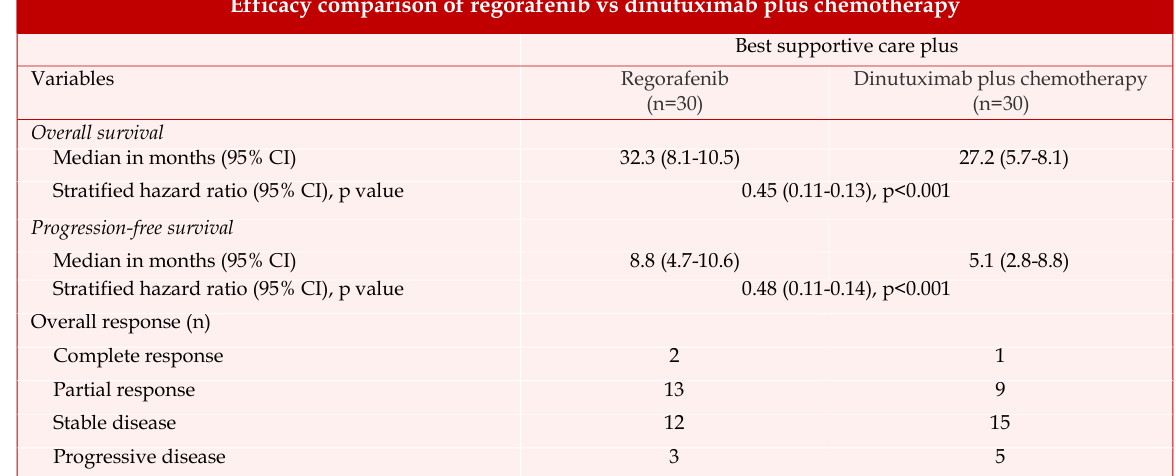
Efficacy comparison of regorafenib vs dinutuximab plus chemotherapy